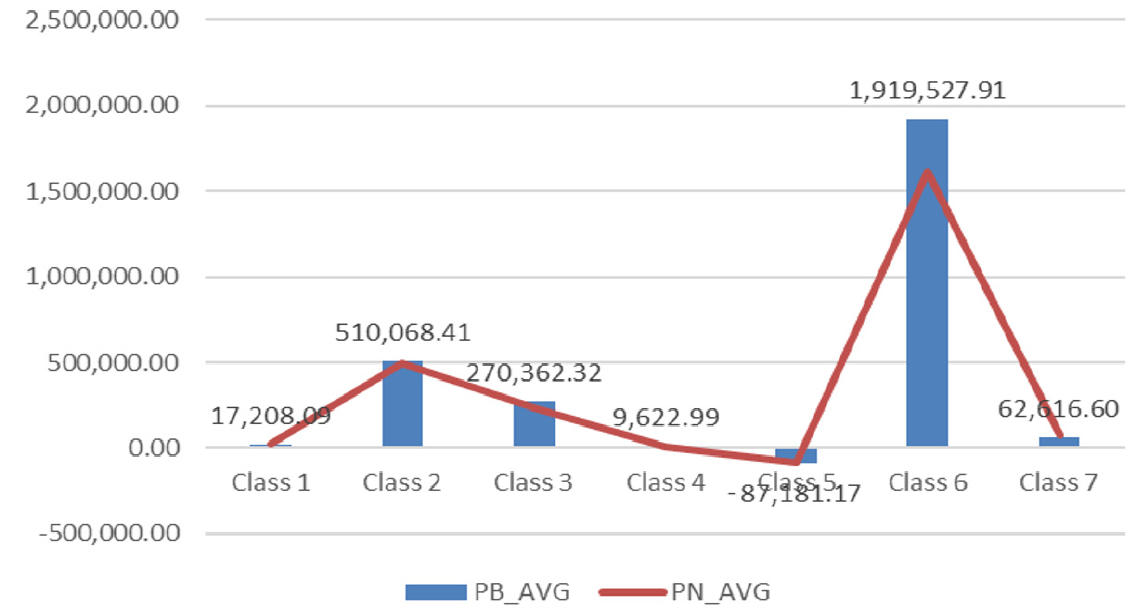
Figure 2. Regional distribution of profitability by industries during 2012–2017. Source: Authors’ processing based on the information provided on Topfirme.com. Accessed date: 5 June 2018.